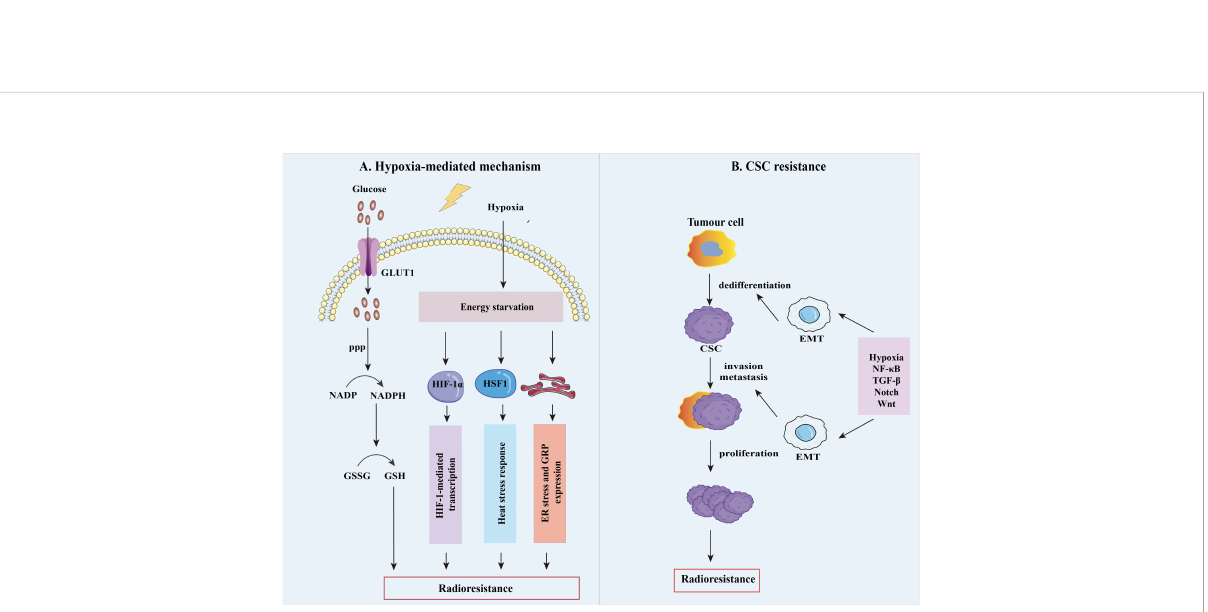
FIGURE 2 The mechanisms of tumor radioresistance. (A) Tumor hypoxia is thought to be an important factor responsible for the radiation resistance of solid tumors, as oxygenation is vital for the ef fi cacy of RT. Hypoxia has a fundamental impact on the resistant phenotype of tumors by upregulating various factors such as HIFs, glucose-regulated protein (GRP), heat shock transcription factor 1(HSF1), heat shock protein (HSP), which result in the radioresistant hypoxic tumors. (B) Cancer stem cells (CSC) are highly plastic cell groups capable of acquiring different phenotypes and cellular states, evading treatment, and enhancing their ability to grow tumors potently. After irradiation, tumor stem cell plasticity is mainly controlled by TME hypoxic conditions and signaling, including nuclear factor- k B (NF- k B), transforming growth factor- b (TGF- b ), Notch, and Wnt. Meanwhile, epithelial-mesenchymal transition (EMT) plays an essential metabolic reprogramming role in this process, allowing cancer cells to be dedifferentiated into CSCs to reach distant metastatic sites.